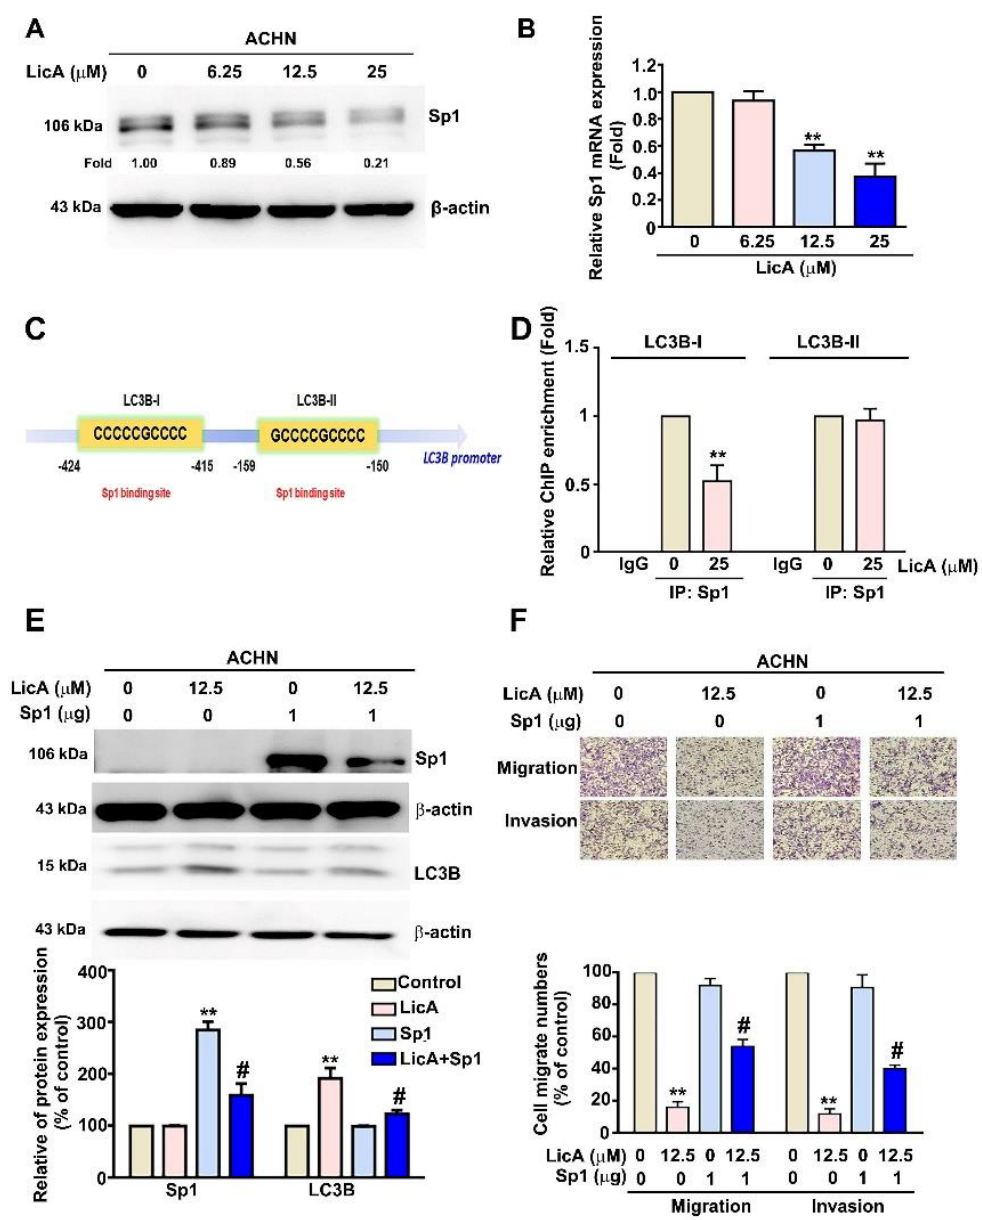
Figure 5. LicA inhibits cell migration and invasion by Sp1-targeted LC3B expression in RCC cells. ACHN cells were incubated with various concentrations of LicA (0, 6.25, 12.5, and 25 µ M) for 24 h. Sp1 expression was verified using ( A ) Western blotting with β -actin used as a loading control and ( B ) RT-qPCR assay with GAPDH used as a loading control. ( C ) The transcription factor binding site of Sp1 for LC3B promoter. ( D ) Cells were treated with 25 µ M and immunoprecipitated with antiSp1 or control IgG and then assessed using ChIP assay (shown as relative quantitative results). ( E ) The Sp1 plasmid was subsequently transfected into ACHN cells for 6 h, which were then exposed to 0 and 12.5 µ M of LicA for 24 h. Western blotting was utilized to analyze the expression of the Sp1 and LC3B proteins, with β -actin serving as a loading control. ( F ) Using a migration assay and a Matrigel-invasion experiment, migration and invasion were assessed. The quantity of migrating or invaded cells is represented as a histogram chart in the lower panel. The data represent the mean ± SD of at least three separate experiments. ** p < 0.01, compared to untreated control (0 µ M); # p < 0.05, compared to LicA-treated